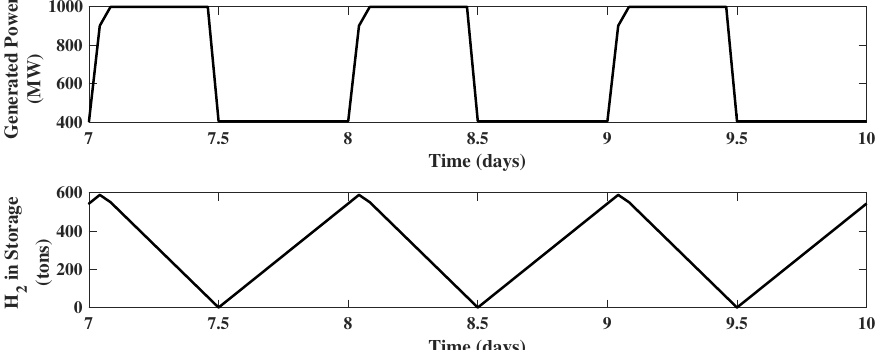
Figure 3. Closed-loop simulation of Economic Model Predictive Control (EMPC) using a 24 h prediction horizon for Example